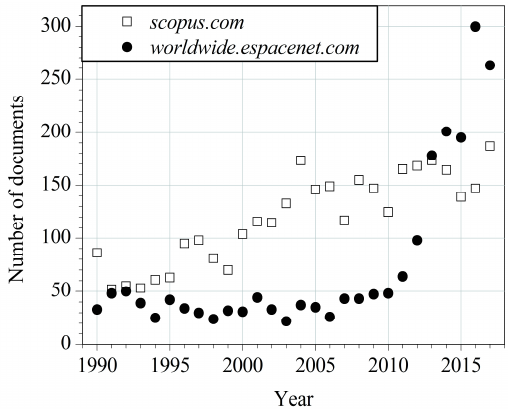
Figure 1. Number of scientific articles and patent documents containing the keyword “rosin” in the years 1990-2017. years